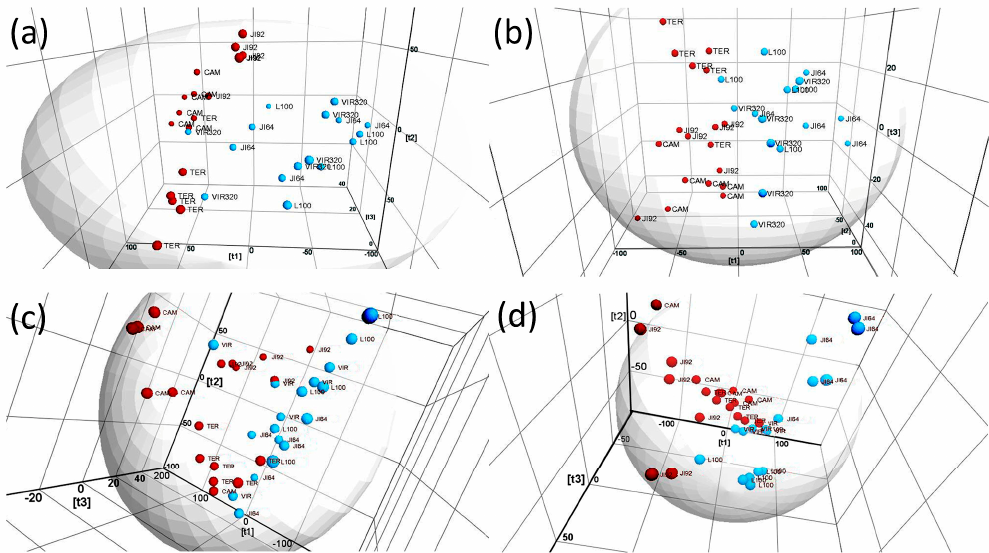
Figure 1. 3D Score plots obtained by Principal Component Analysis of MALDI-MS and LDI-MS data. Upper plots—measurement in negative ionization mode, ( a ) with matrix and ( b ) without matrix; bottom plots—measurement in positive ionization mode, ( c ) with matrix and ( d ) without matrix; dormant species are marked with blue and non-dormant ones with red bullets; Pareto scaling and marker intensity threshold 1000 was used for data matrix processing.